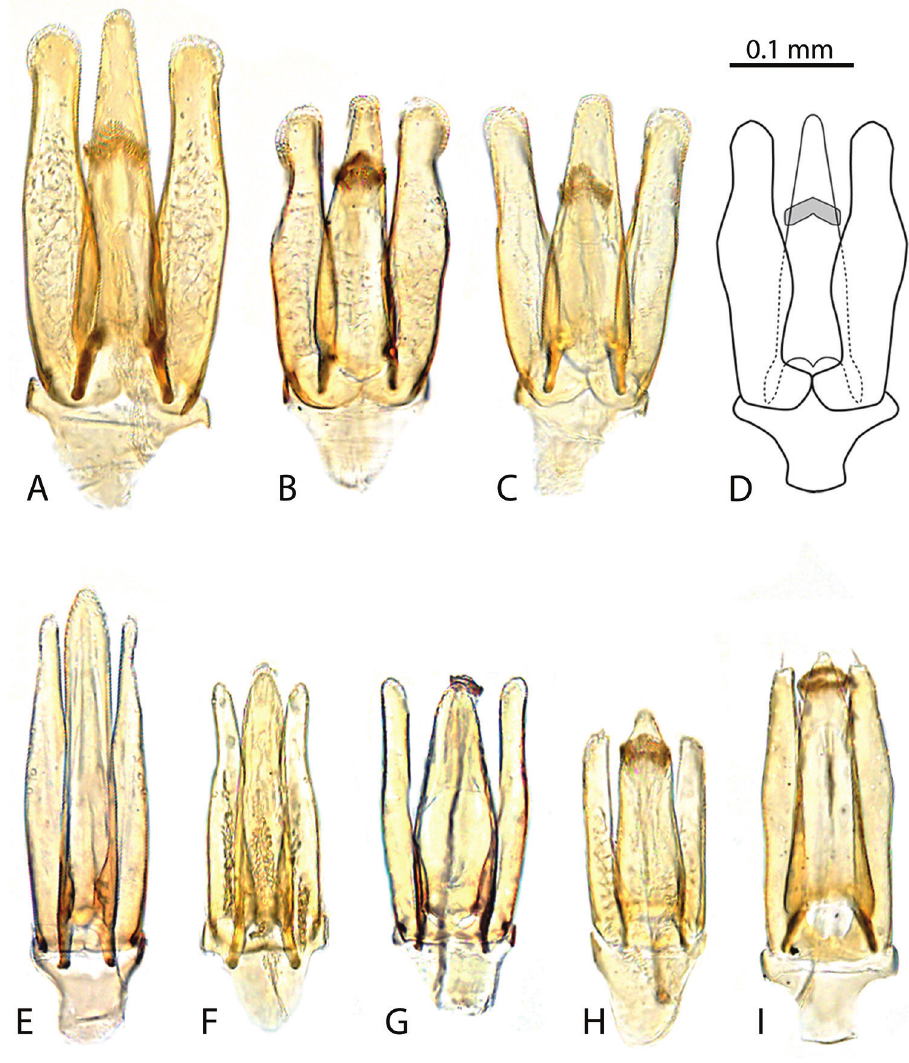
Figure 14. Aedeagi (ventral view) of Tobochares spp. A T. kusad sp. n. B T. sulcatus C T. sipaliwini D T. striatus E T. kasikasima F T. pallidus sp. n. G T. canaliculatus sp. n. H T. canthus sp. n. I T. emarginatus sp. n. seepages/ 12.iii.2012; SR12-0312-01A/ 2012 CI-RAP Survey” (NZCS). Para types (11): SURINAME: Sipaliwini District: Same data as type (3 exs., SEMC, one mount- ed on SEM stub); Camp 1, Upper Palumeu, 10.iii.2012, leg. A. Short, small forest pool by boulders, SR12-0310-02A (1 ex.; SEMC); Camp 4 (Kasikasima), 24.iii.2012, leg. A. Short, main seepage area, SR12-0324-01C (7 exs., SEMC, NZCS). Additional material examined (1). Camp 4 (Kasikasima), 24.iii.2012, leg. A. Short, main seepage area, SR12-0324-01C (1 ex., SEMC; DNA voucher